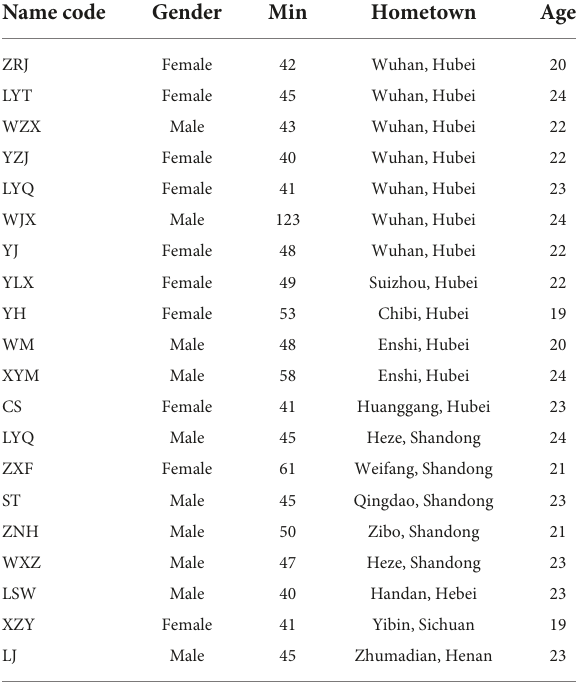
TABLE 1 Summary of basic information of